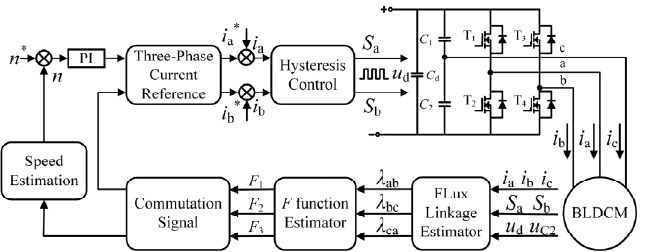
Figure 7. The position sensorless control system for BLDCM driven by FSTPI based on flux-linkage function.